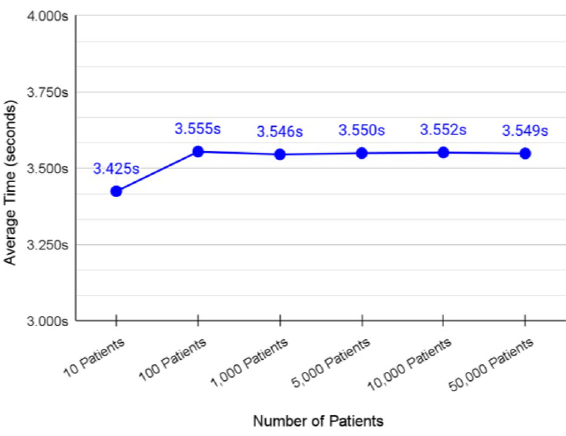
Figure 12. Average transaction speed of adding patients to authority shard.